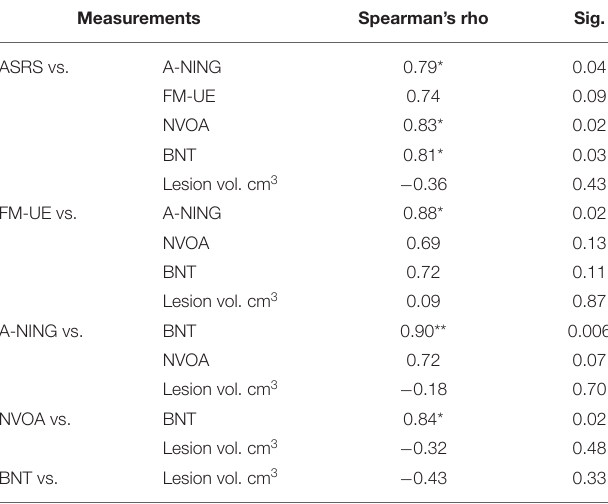
TABLE 8 | Relation recovery ratios in the group with severe aphasia ( n = 7).